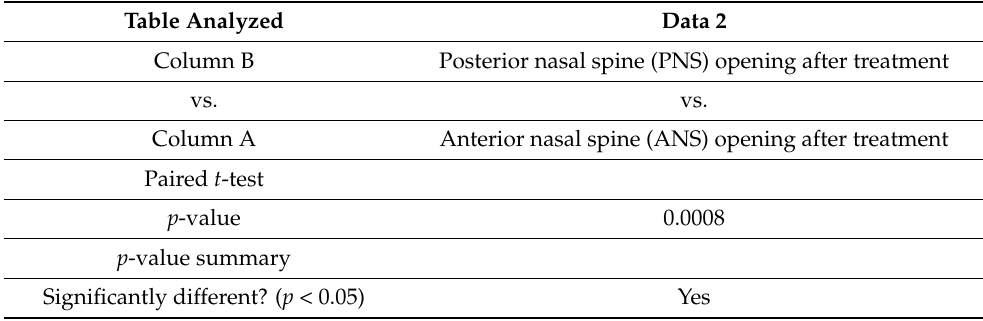
Table 2. Comparison of the magnitude of the split at the PNS and ANS. Table